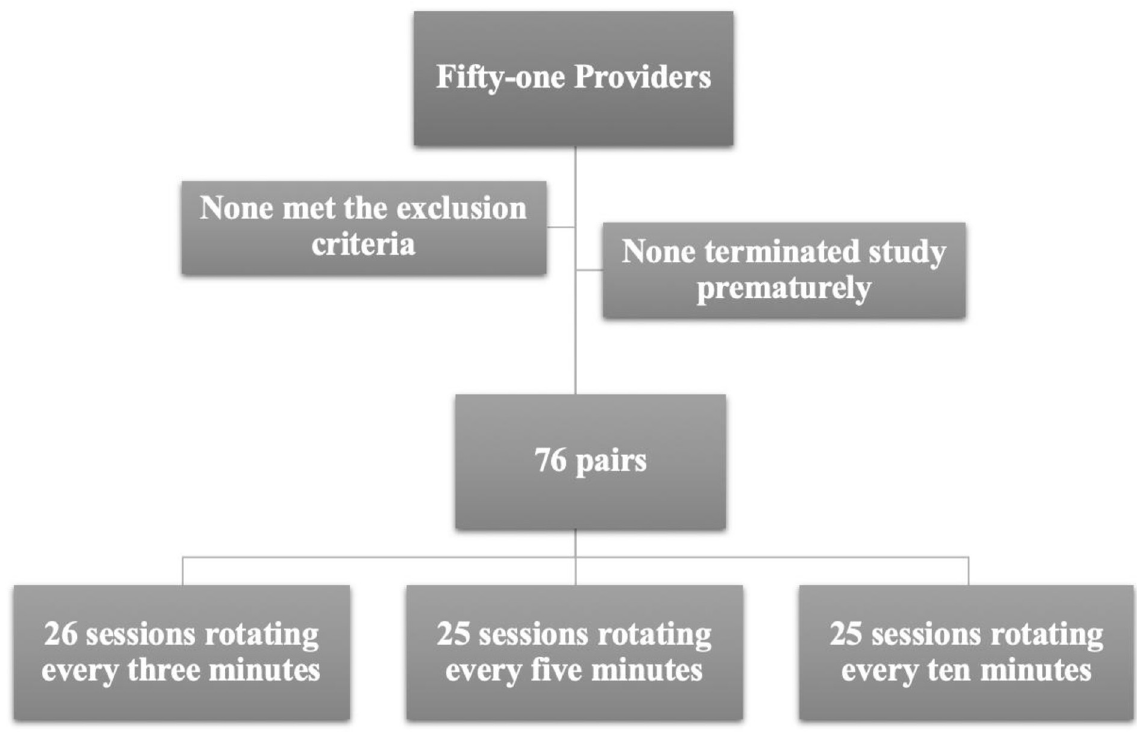
Fig 2. CONSORT algorithm illustrating study enrolment and reporting number of sessions under each study arm. Note that, one additional provider (with a total of 51 as oppose to initially determined 50 providers) was enrolled due to error in the pairing process.